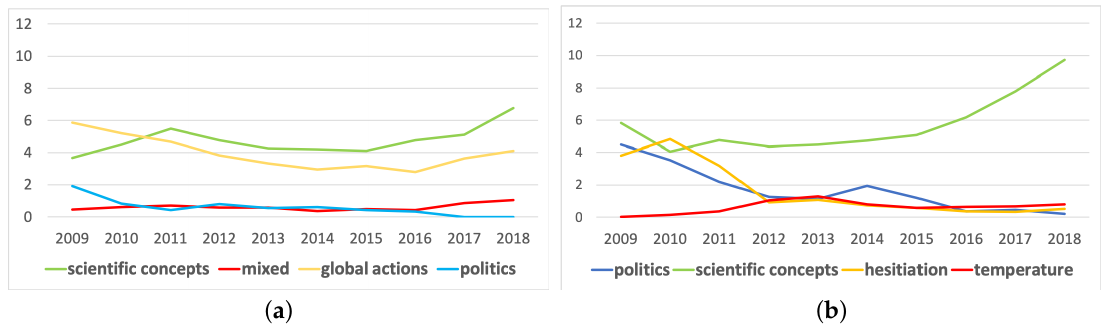
Figure 5. The sum of centrality for nodes in four clusters in the climate change discourse from 2009 to 2018 ( a ); (the sum of centrality for nodes in four clusters in the global warming discourse from 2009 to 2018 ( b ).